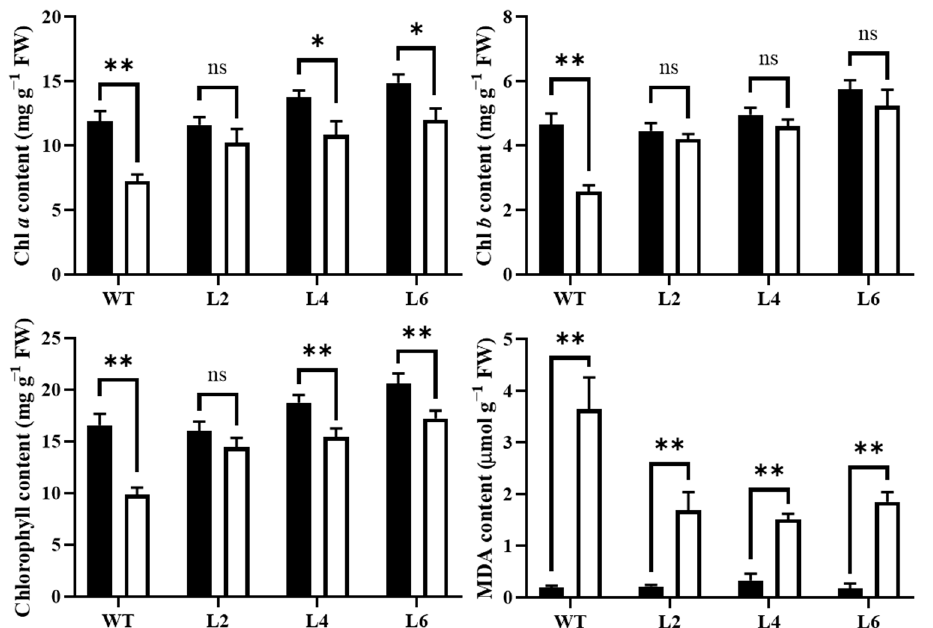
Figure 8. Chlorophyll and MDA contents of TaPsb28 -overexpressing Arabidopsis seedlings exposed to drought treatment. The black column represents the plants treated by normal watering, while the white column represents the plants subjected to drought stress by withholding irrigation for 14 days. Data are expressed as the means ± SDs ( n = 3). “**” and “*” indicate statistically significant differences between the CK and drought treatments at p < 0.01 and 0.05, respectively, while “ns” represents nonsignificant differences between the two treatments at the level of p < 0.05.